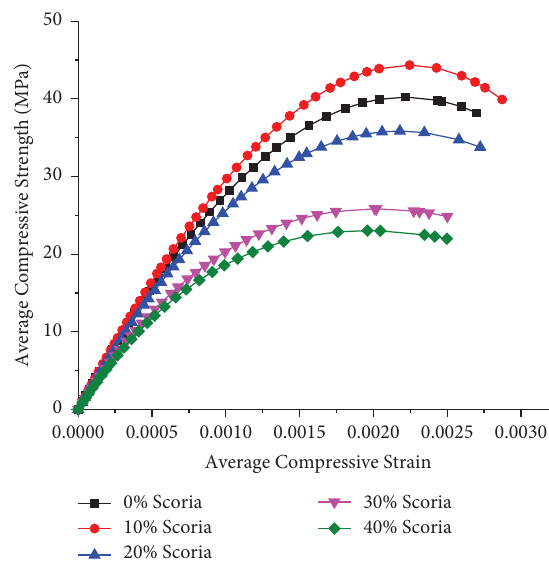
Figure 10: Stress-strain curve for 56 days compressive strength results.